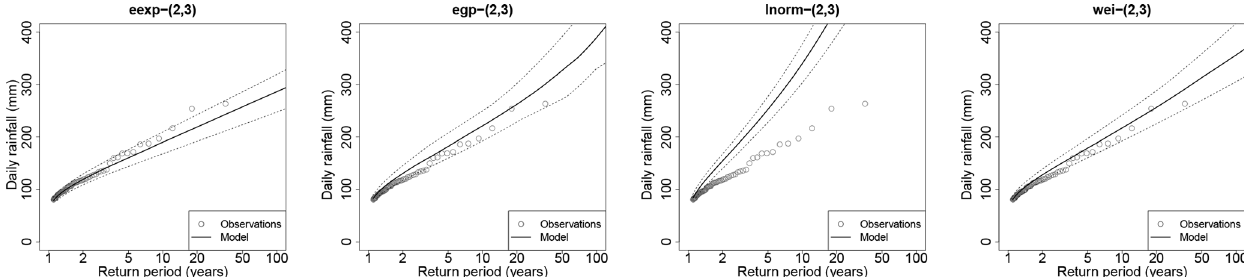
Figure 9. Case of Antraigues when G s,k is either the extended exponential (eexp), extended generalized Pareto (egp), lognormal (lnorm) or Weibull (wei) distribution, with S = 2 and K = 3. The dotted lines show the 95% envelope of return level estimates over the 100 subsamples. The plain line shows the median estimates. The gray points show the full sample (35 years). Each estimation is based on half these points. The case of the Gamma distribution is shown in panel (d) of Fig.